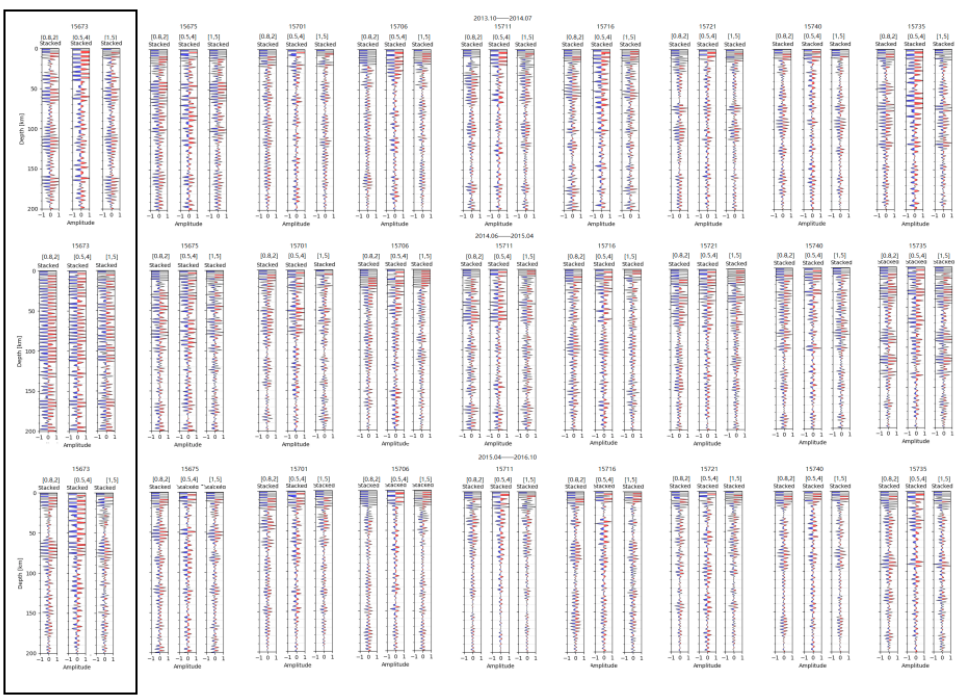
Figure 10. Only teleseismic events 30–90° away from the array are selected.